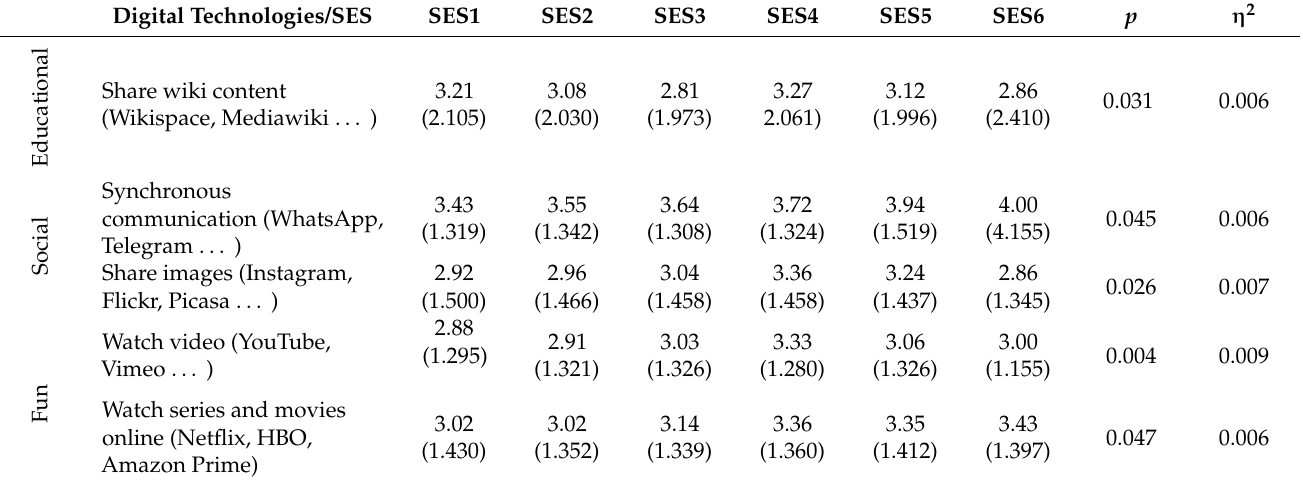
Table 5. Duration according to the socioeconomic stratum (SES1 lower to SES6 higher) as a fixed